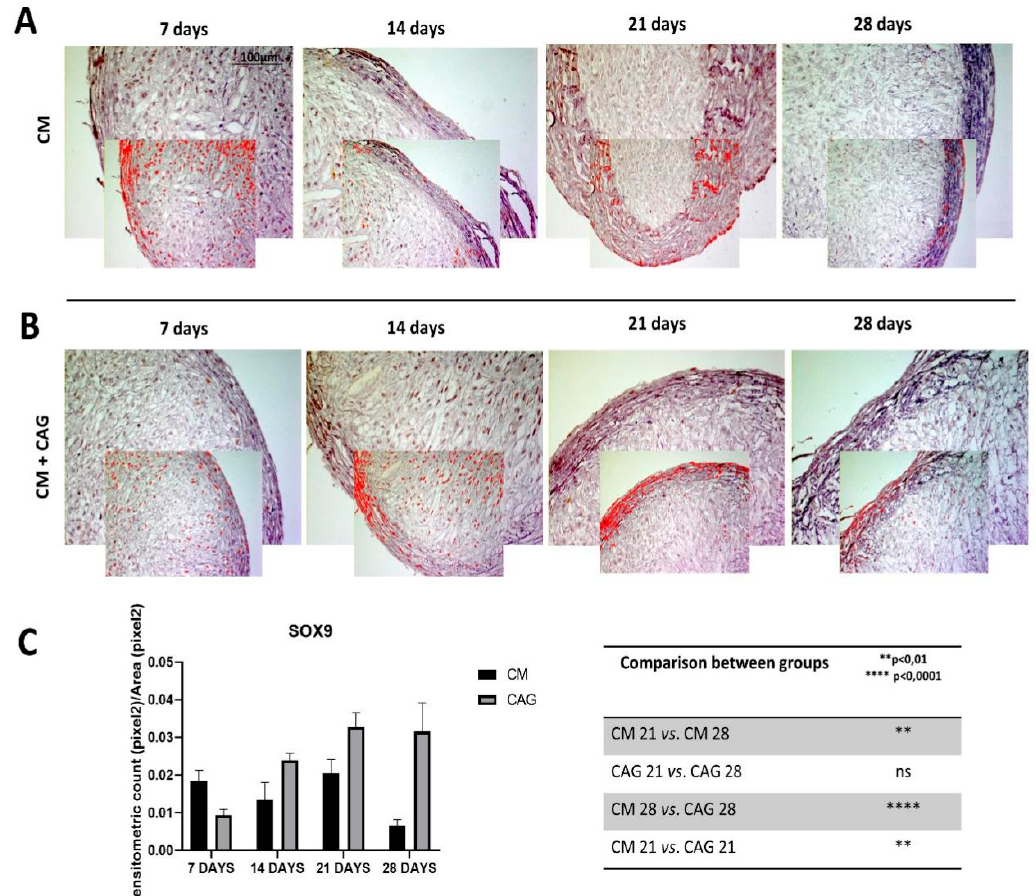
Figure 4. SOX9 immunohistochemical evaluation in 3D AMSC-derived chondropellets at 7, 14, 21, and 28 days of culture through computerized densitometric measurements and image analysis. ( A ) control group (chondrogenic medium: CM); ( B ) CAG-supplemented group (CM + CAG). The smaller attached images represent the image analyses by the software: red color corresponds to brown staining (immune complexes labelled with chromogen). ( C ) Graph representing the level of staining expressed as densitometric count (pixel 2 ) normalized to the area of each section expressed in pixel 2 . Results were presented as the mean ± SD. ANOVA was used to evaluate the significance of the results. ** p < 0.01; **** p < 0.0001; ns, not significant. See the Materials and Methods section for details. ( A , B ) Objective lens, 10×; scale bar: 100 μ m.